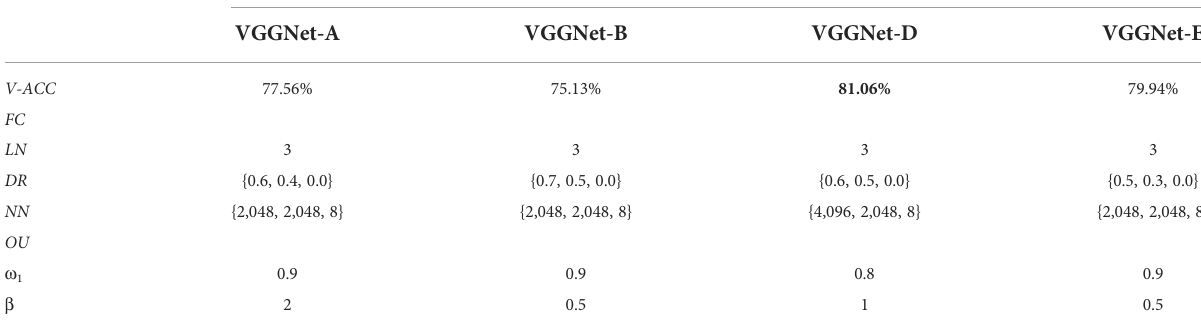
TABLE 3 TD-NAS ( RSDS-0.1K , w 1 not fi xed).